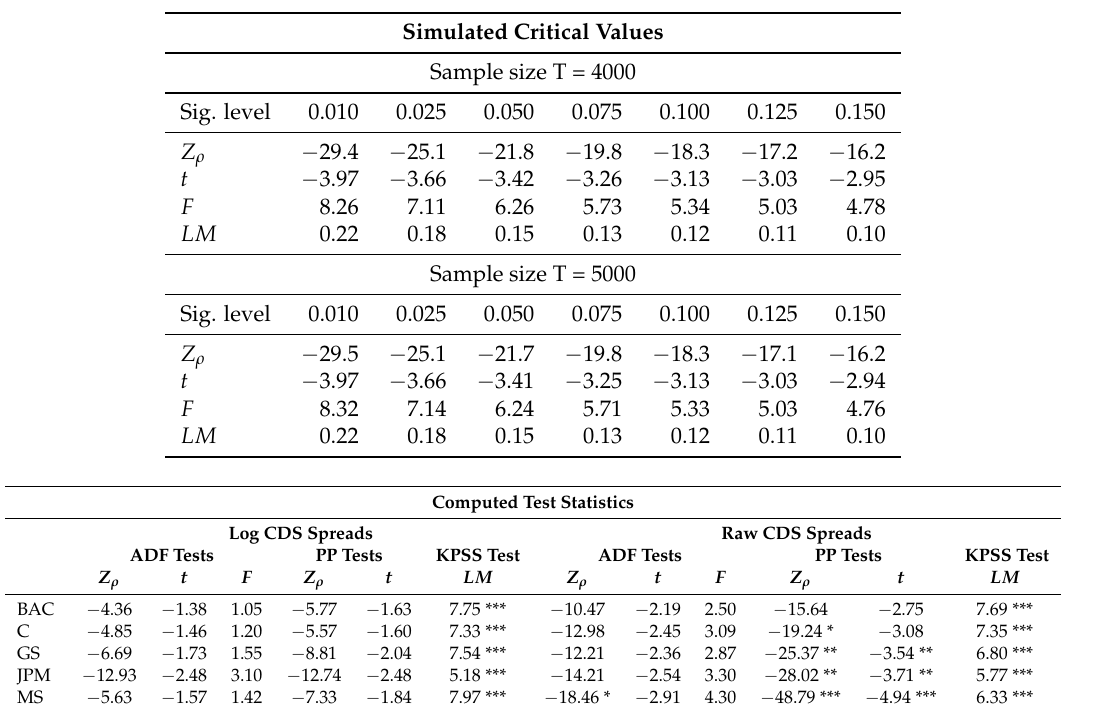
Table 1. Unit root and covariance stationary